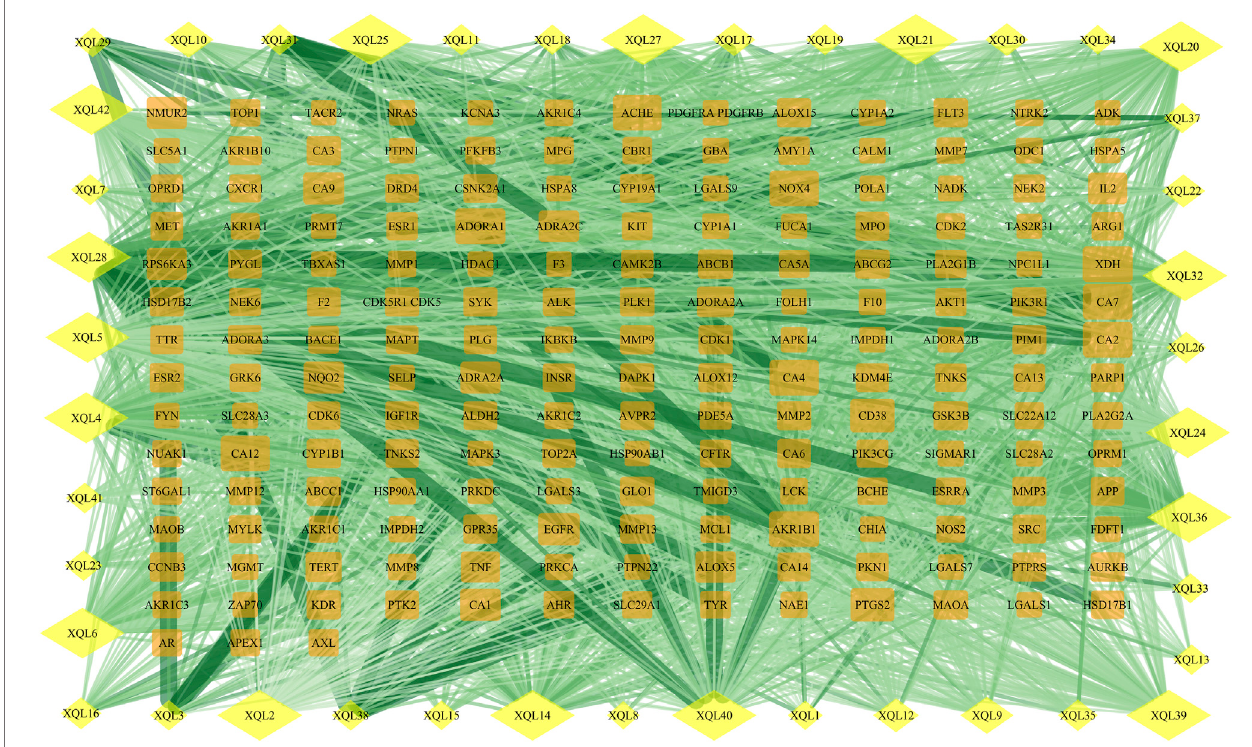
FIGURE6| ProteinnetworkofTFDM-relatedtargets.Yellowdiamondsrepresent fl avonoids,andorangerectanglesrepresentpotentialtargetsofthecompounds.